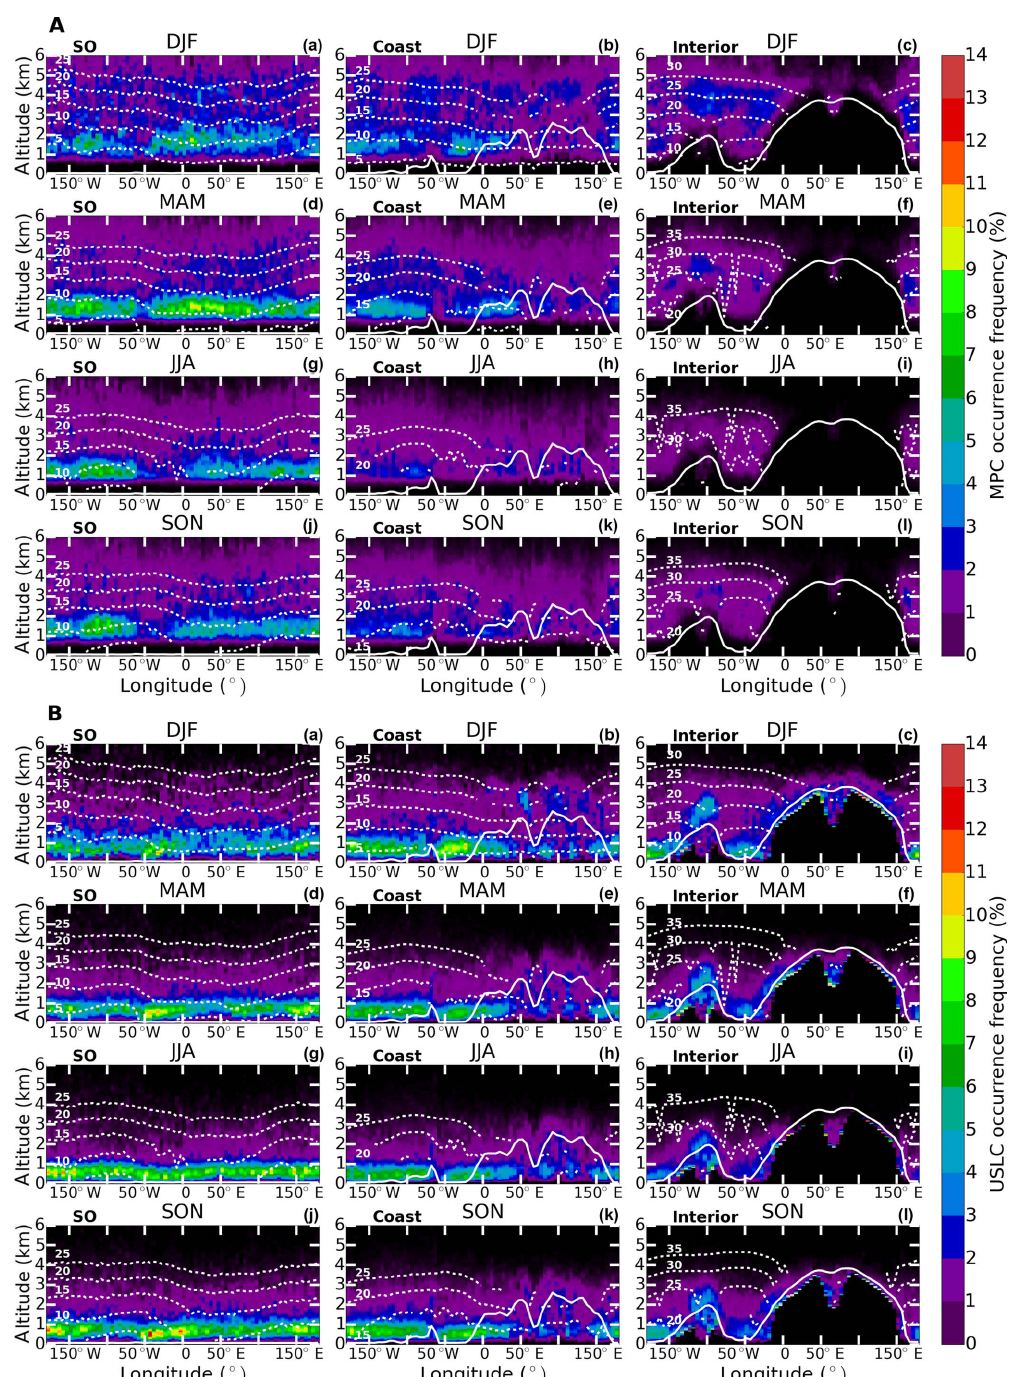
Figure 8. (A) Same as Fig. 7A but for the MPC fraction. (B) Same as (A) but for the USLC fraction. Additionally, isotherms are shown every 5 ◦ C (dotted white lines) and they are labelled but ignore the minus sign in the temperature value. The warmest temperature shown in all panels is − 5 ◦ C. In plots (Aa) to (Ak) and (Ba) to (Bk) (SO and coastal transects) isotherms are shown down to − 25 ◦ C only, while for the interior transects they are shown down to − 35 ◦